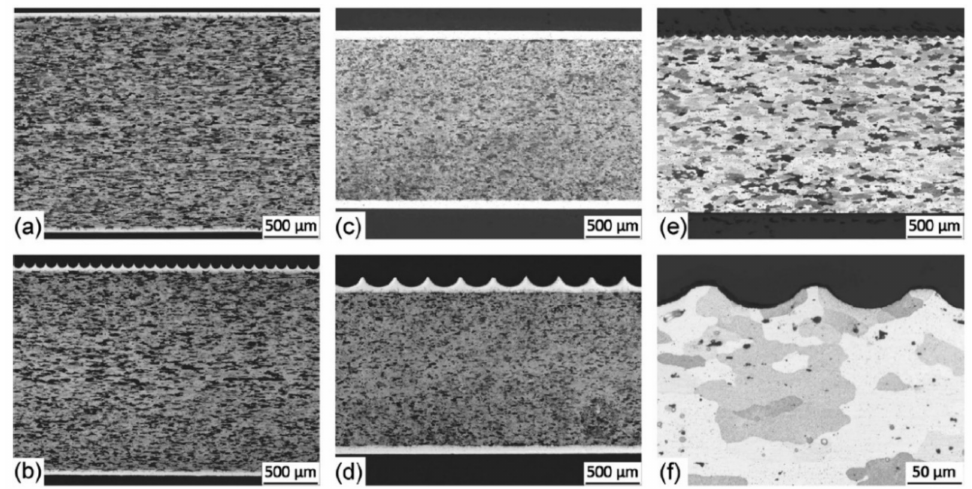
Figure 15. Polished cross-sections. ( a ) A 2 mm thick AA 2024-T351 sheet combined with a clad layer of commercially pure Al (Alclad 2024-T351). ( b ) Structured sheet of Alclad 2024-T351 with 80 µ m riblet diameter. ( c ) A 1.6 mm thick Alclad 2024-T351 sheet. ( d ) Structured sheet of Alclad 2024-T351 with 300 µ m riblet diameter. ( e , f ) A 2 mm thick AA2024-T351/T4 bare sheet with 100 µ m riblet diameter, reproduced from [54], with permission from Elsevier,